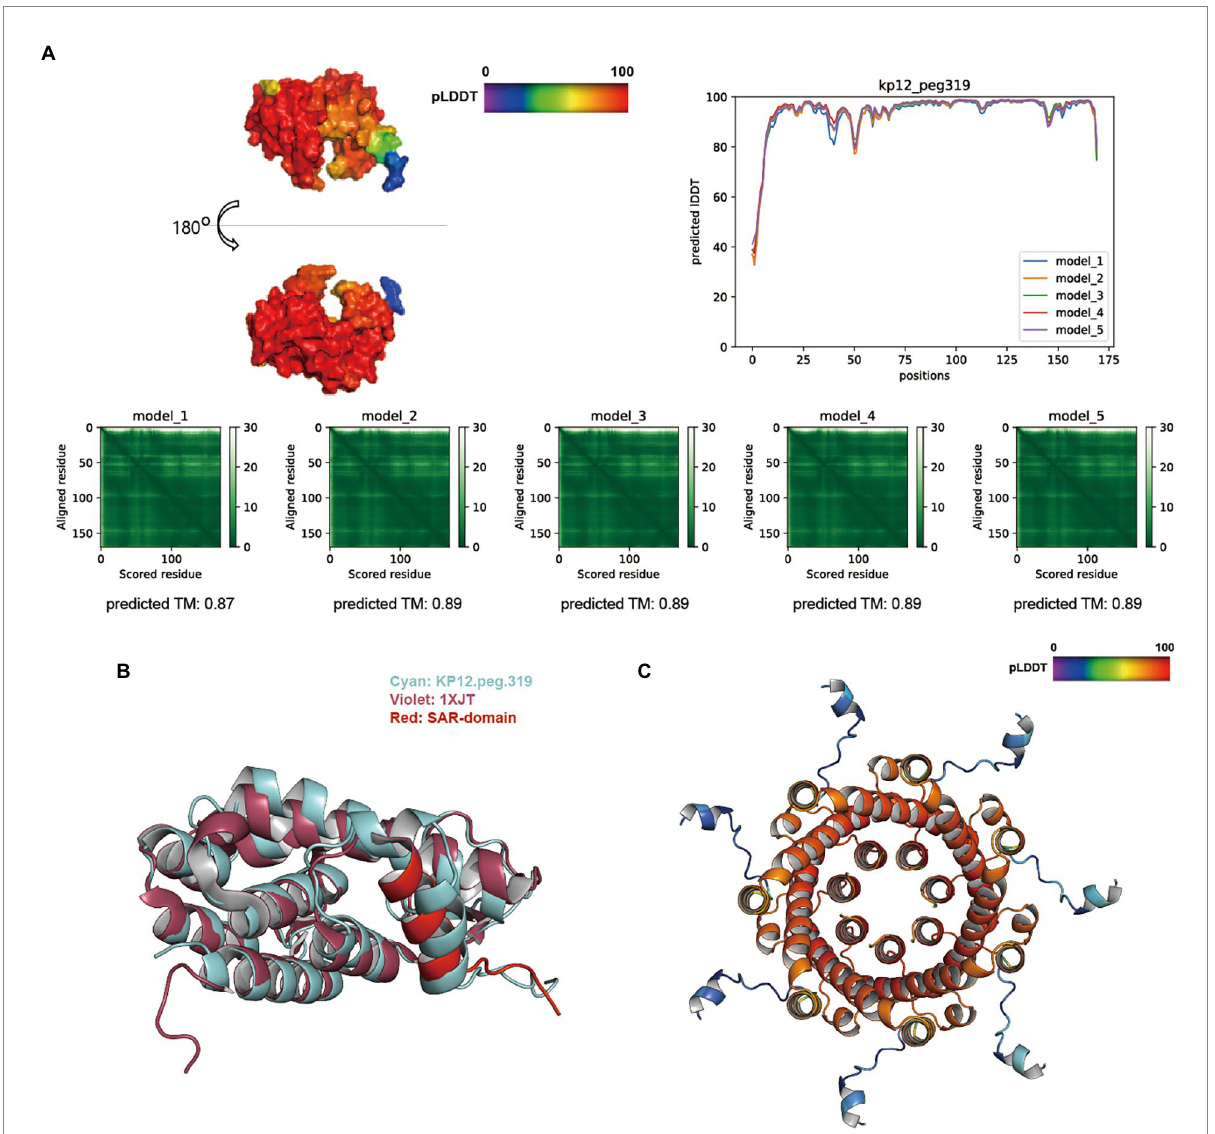
FIGURE 6 Structure prediction of putative host-lytic proteins in KP12 and their alignments with X-ray crystal structures. (A) AlphaFold models generated for KP12.peg.319 show high pLDDT and predicted TM-scores. Protein surface structure of the first pTM model (model_1; top left), and its corresponding 2D plot showing the score for amino acid at each position (top right) are color-coded according to its pLDDT. PAE heatmaps of five models and their pTM scores illustrate the predicted error between all pairs of residues. The lower value (darker green) indicates higher confidence in the prediction. (B) Structural alignment of the KP12.peg.319 model (cyan) to P1 endolysin Lyz (PDB ID: 1XJT, violet). The SAR domain of Lyz is marked in red. (C) The predictive homoheptamer of KP12.peg.280 (putative holin) is color-coded according to the pLDDT score of its pTM